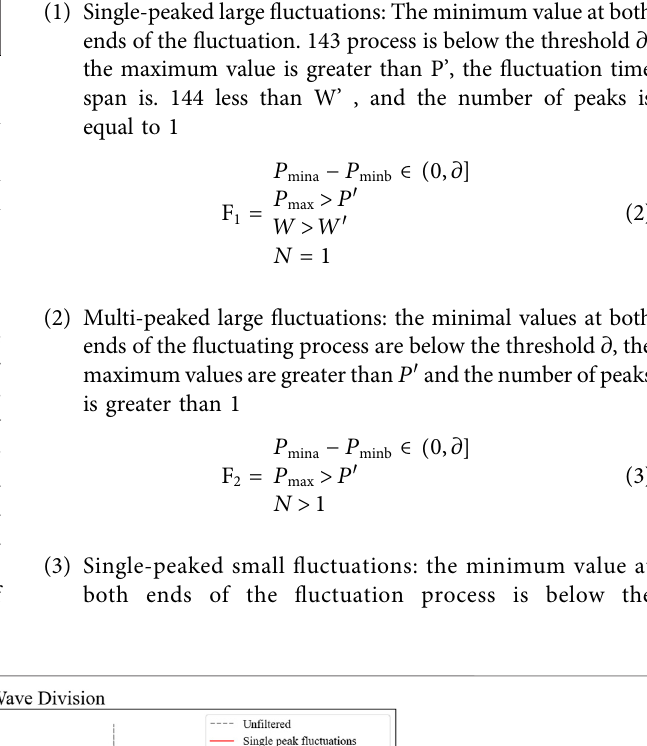
Frontiers in Energy Research |